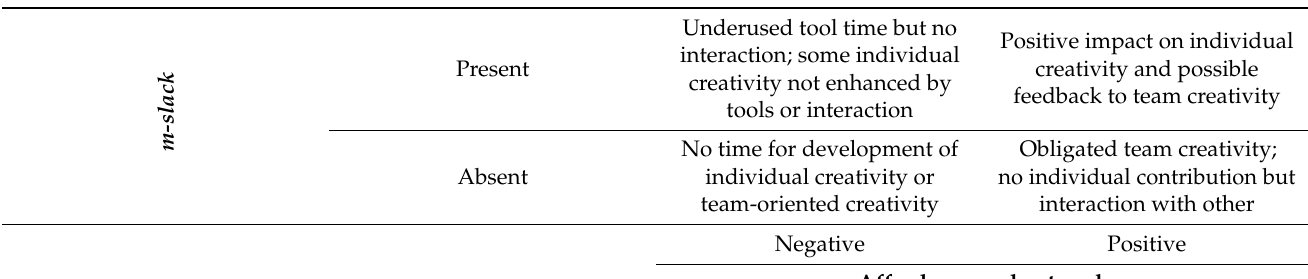
Table 5. m-slack combined with affordance and network